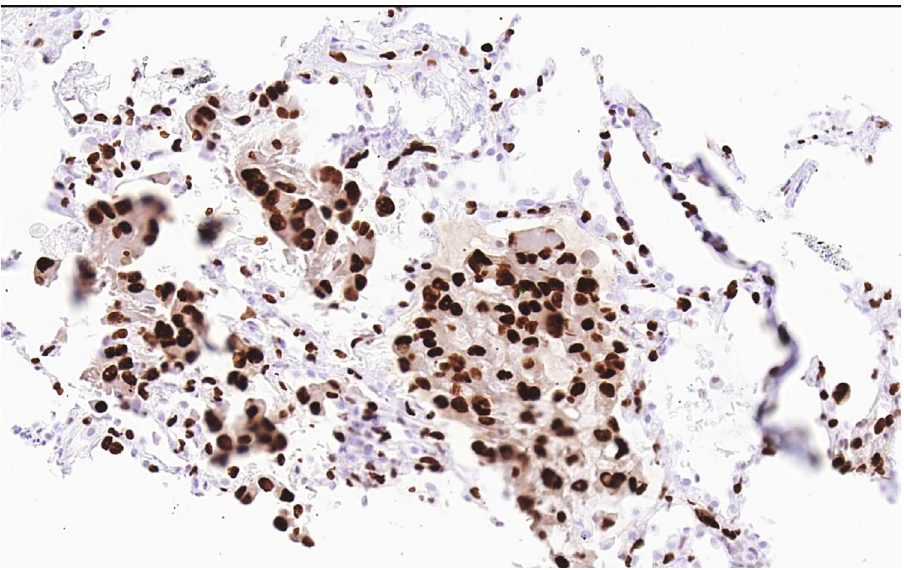
Figure 5: Immunohistochemical stain showing uptake of